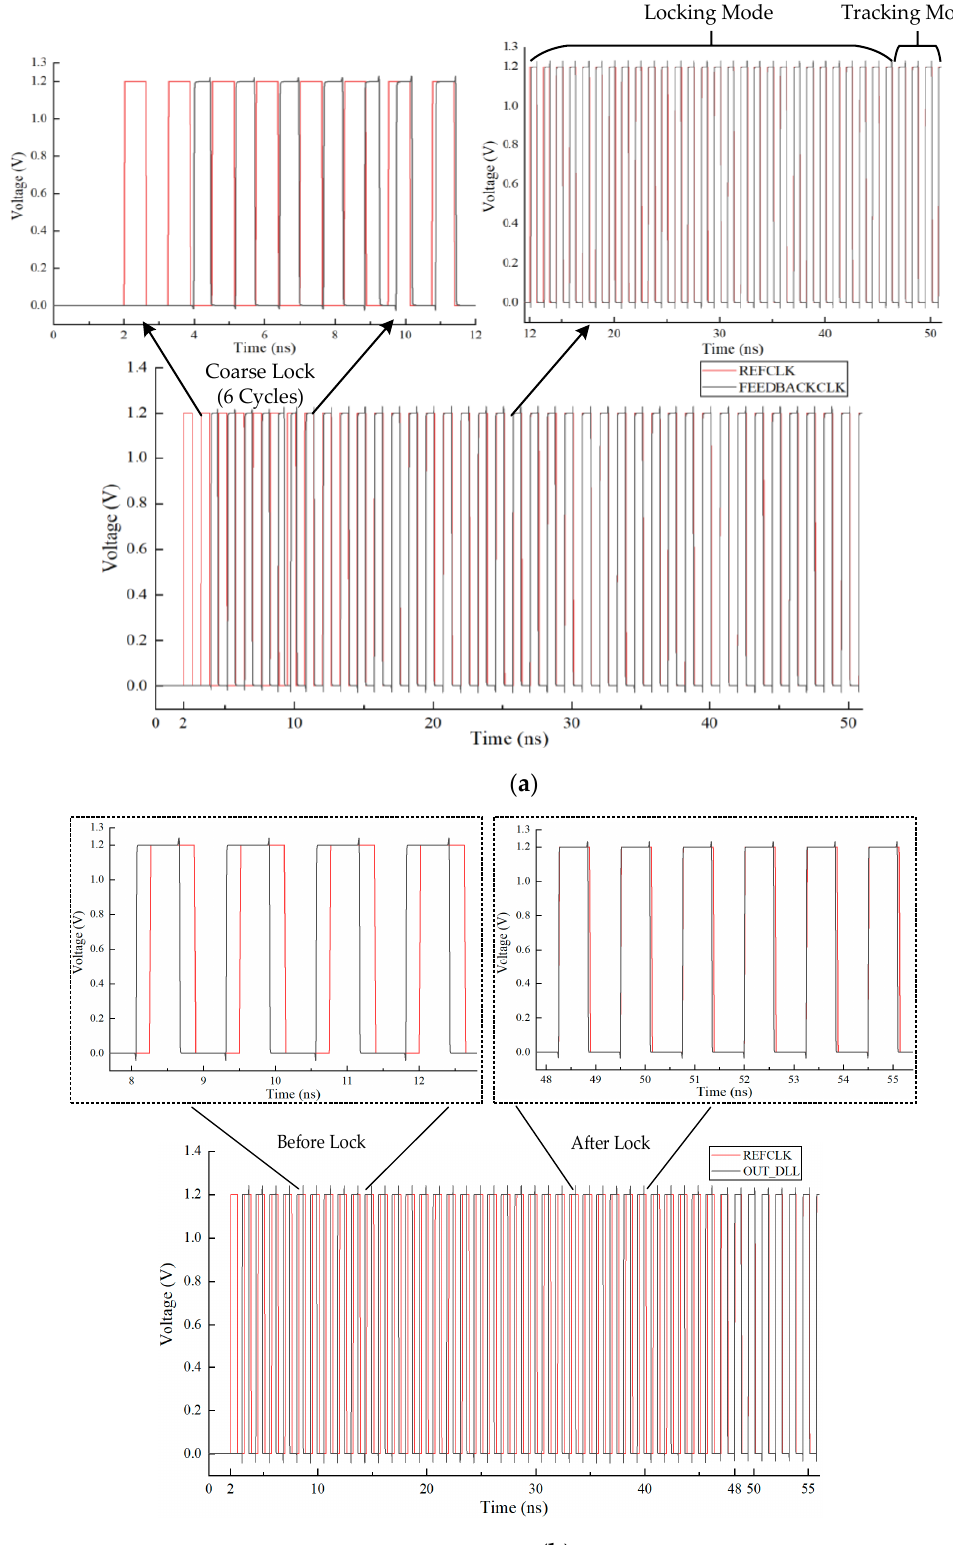
Figure 17. ( a ) Locking process of the main delay line at 800 MHz; ( b ) State of the replica delay line at 800